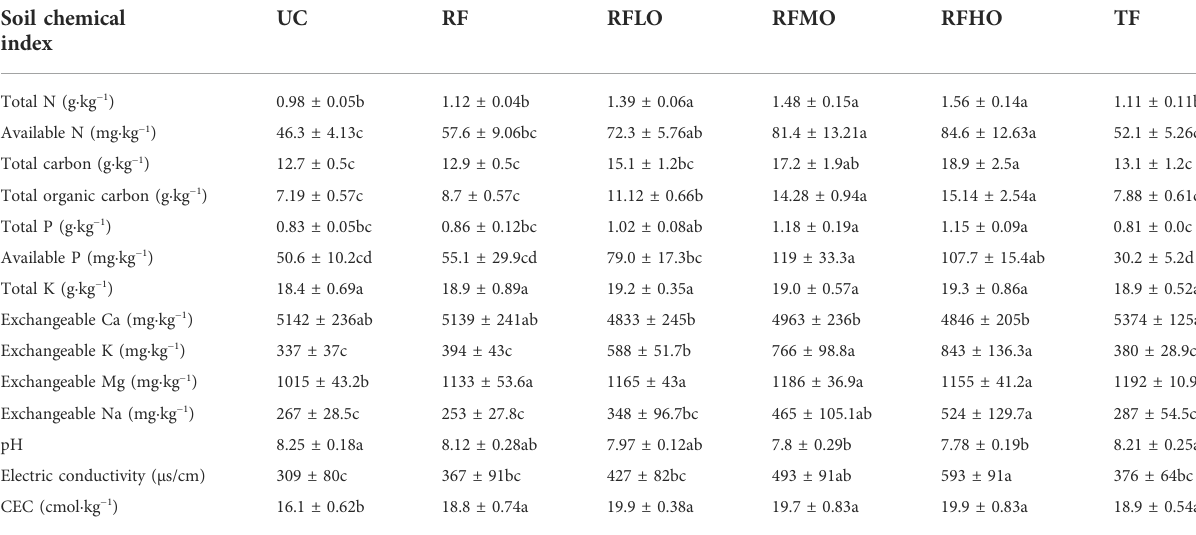
TABLE 3 Soil chemical variables under each soil fertilizer management practice at 0 – 20 cm soil depth.